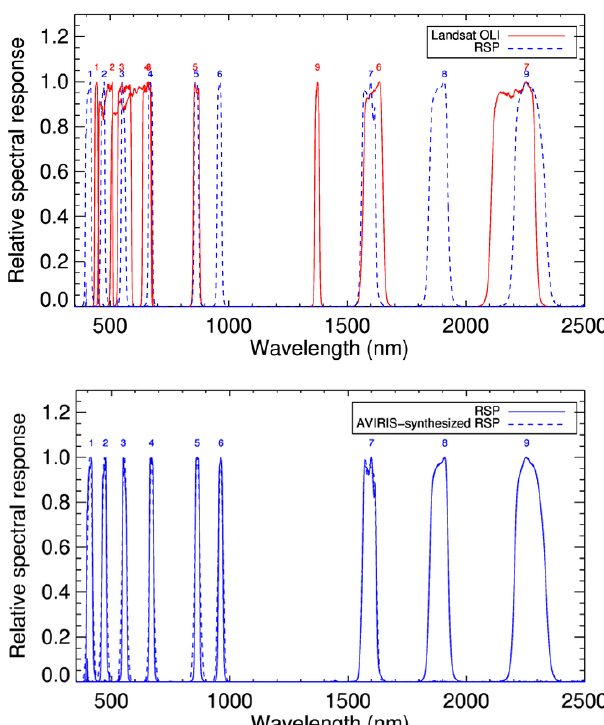
Figure 1. (a) Spectral responses of Landsat 8 OLI as a solid red line and RSP as a dashed blue line. (b) AVIRIS spectral channels are ap- proximately 10nm wide and Gaussian-shaped with 10nm spacing from 365 to 2495nm, and weighted sums (dashed lines) have been used to match the RSP spectral channels (solid